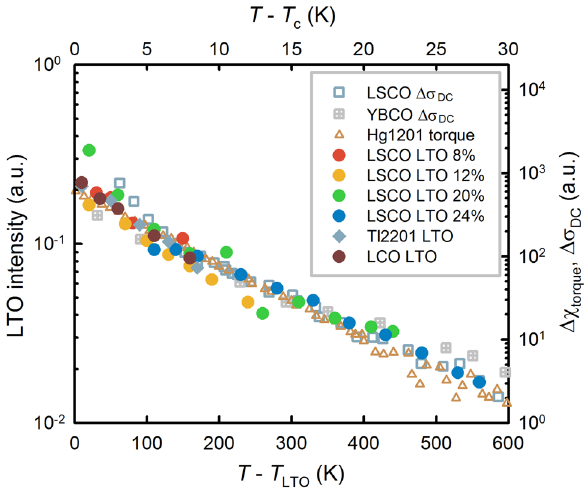
Figure 4. Comparison between orthorhombic and superconducting fluctuations. The diffuse peak intensities from Fig. 3a (left vertical scale, bottom horizontal scale) fall on the same universal exponential curve when the temperature is shifted by T LTO , similar to the effective linewidths (Fig. 3b). The Tl2201 data have been multiplied by a constant to match the LSCO scaling. Signatures of superconducting fluctuations (right vertical scale, top horizontal scale) follow a similar exponential behaviour when shifted by T c , independent of cuprate family and doping. As representative examples, we show the superconducting contribution to the normal-state conductivity (paraconductivity, Δσ DC ) for underdoped LSCO with x = 0.1 ( T c = 28 K) 76 and optimally doped YBa 2 Cu 3 O 6+δ (YBCO, T c = 93 K) 77 , as well as torque magnetometry results 15 for underdoped HgBa 2 CuO 4+δ (Hg1201,